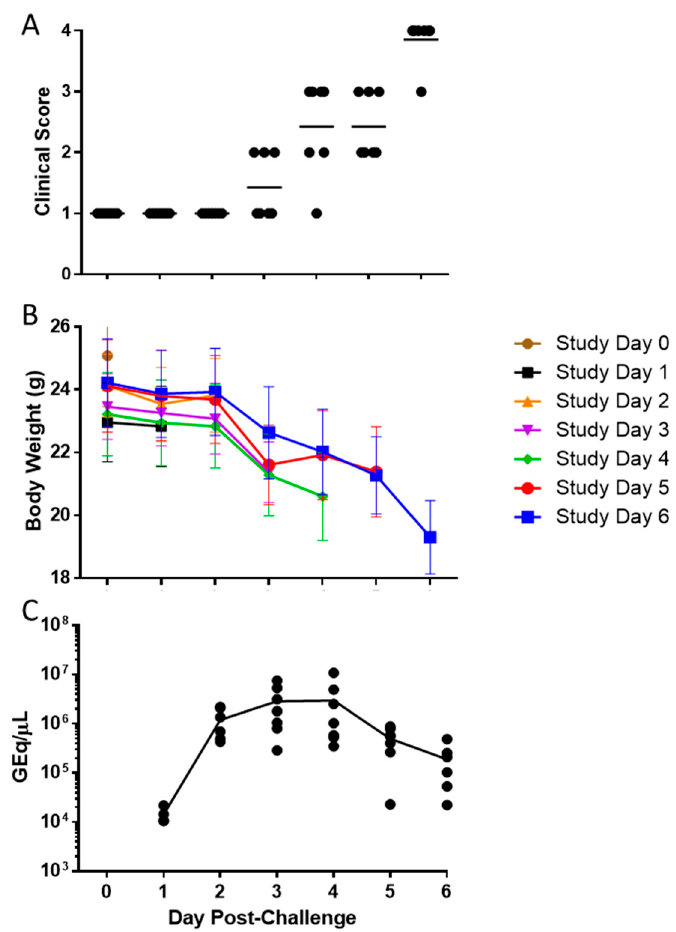
Figure 3. Clinical Scoring, Weight Loss, and Viremia after EBOV Challenge. Mice were challenged with 1.0 × 10 2 pfu of EBOV and 7 mice were euthanized each from Day 0 through Day 6. Individual clinical scores ( A ) and body weight ( B ) were recorded over time with the horizontal bars indicating means. The levels of viral RNA in serum were also measured at the time of euthanasia and presented in genome equivalents per µL (GEq/µL; C ).